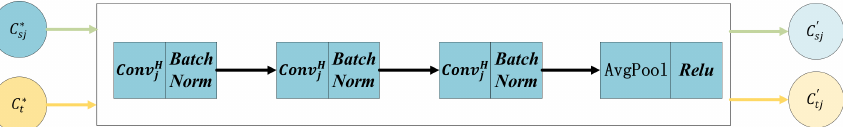
Figure 3. Structure of the feature alignment network based on the bottleneck layer at the j -th nearby monitoring